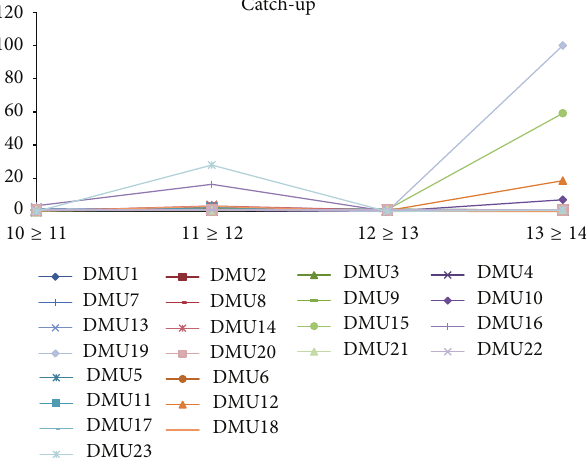
Figure 1: Efficiency change of the India mining industry.